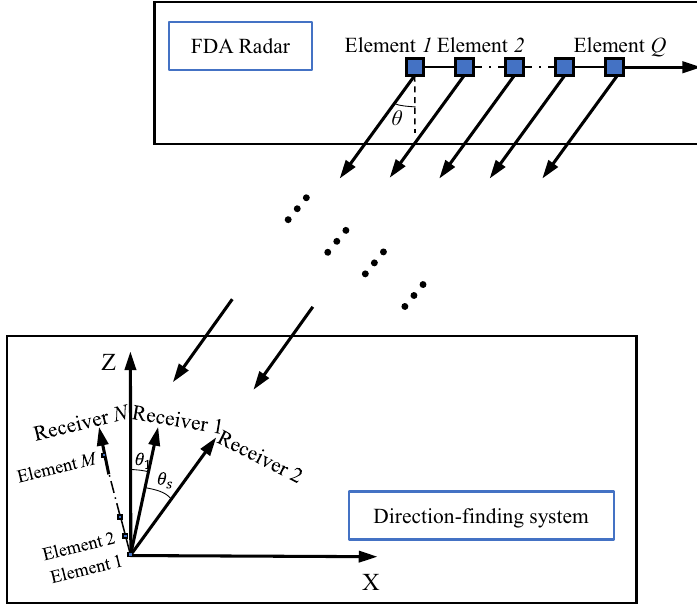
Fig. 4 The position relationship between the direction-finding system and FDA